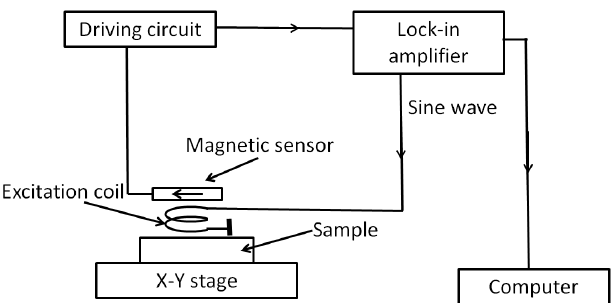
Figure 16. Block diagram of the eddy current testing (ECT) system with the FeCoSiB amorphous wire magnetic sensor.